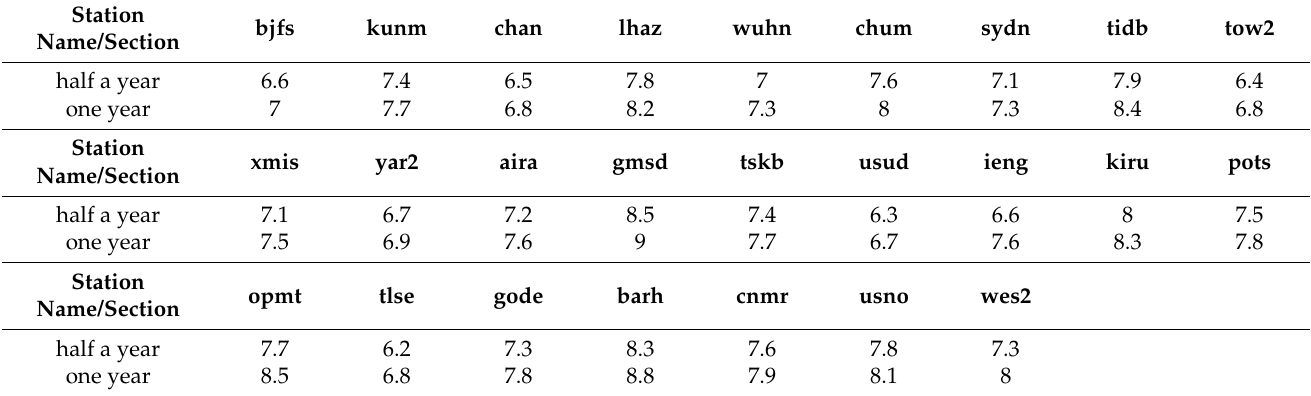
Table 11. RMSE statistics (mm) of residual prediction accuracy of CORS station elevation nonlinear modeling based on